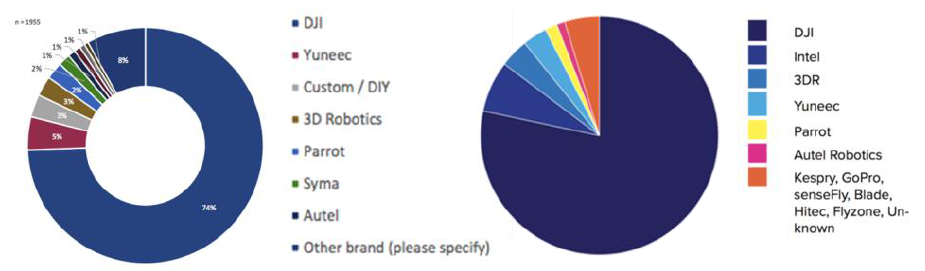
Figure 20. Drone market share.